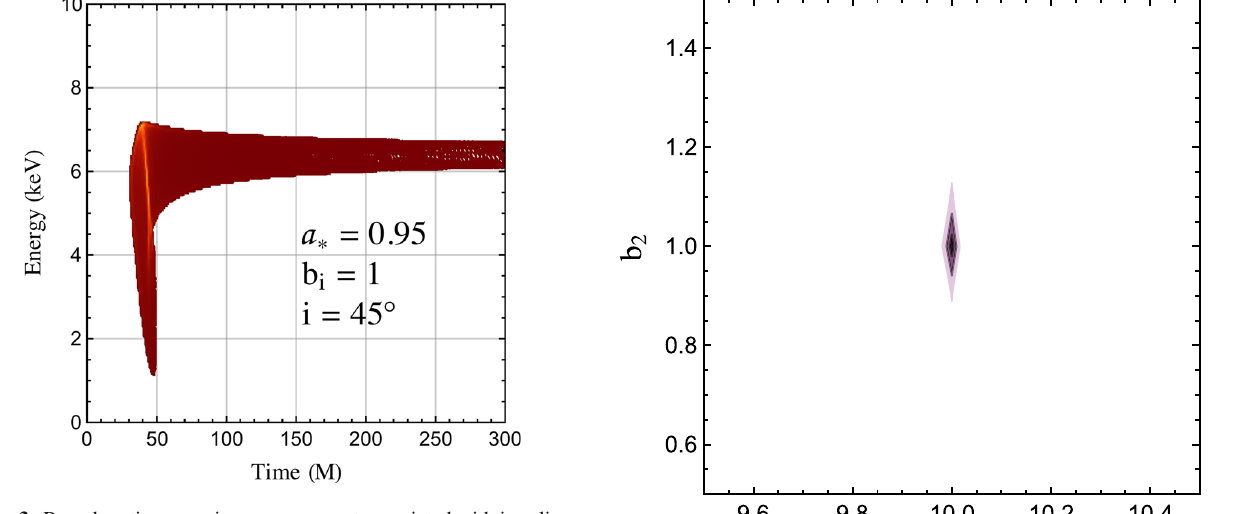
Fig. 3 Reverberation mapping measurement associated with iron line in Kerr spacetime. See the text for more details